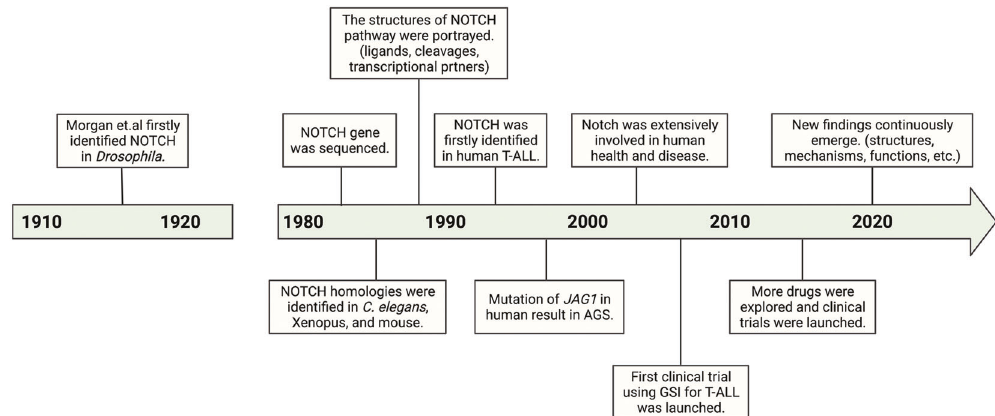
Fig. 1 A brief history of the NOTCH signaling pathway. T-ALL, T cell acute lymphoblastic leukemia; AGS, Alagille syndrome; GSI, γ -secretase